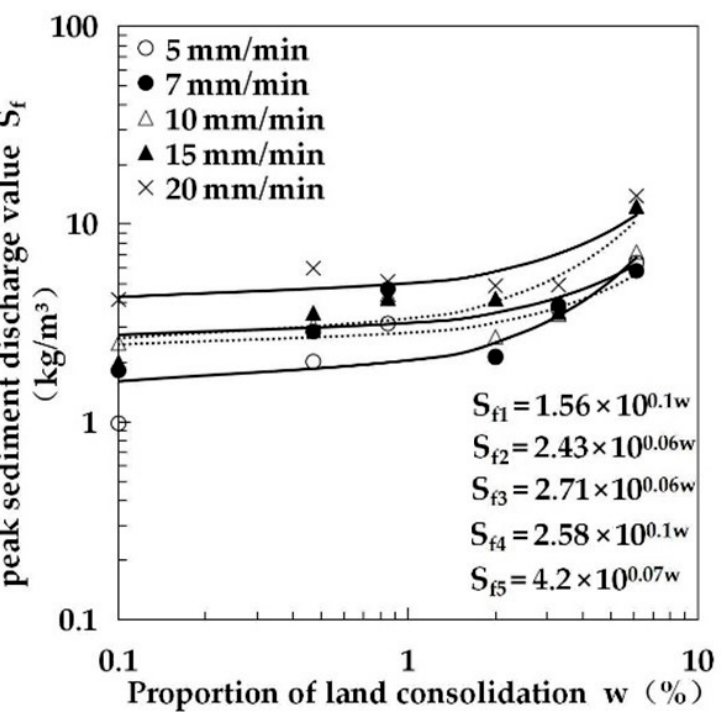
Figure 25. Changes in peak sediment discharge value with land consolidation proportion under different rainfall intensities.